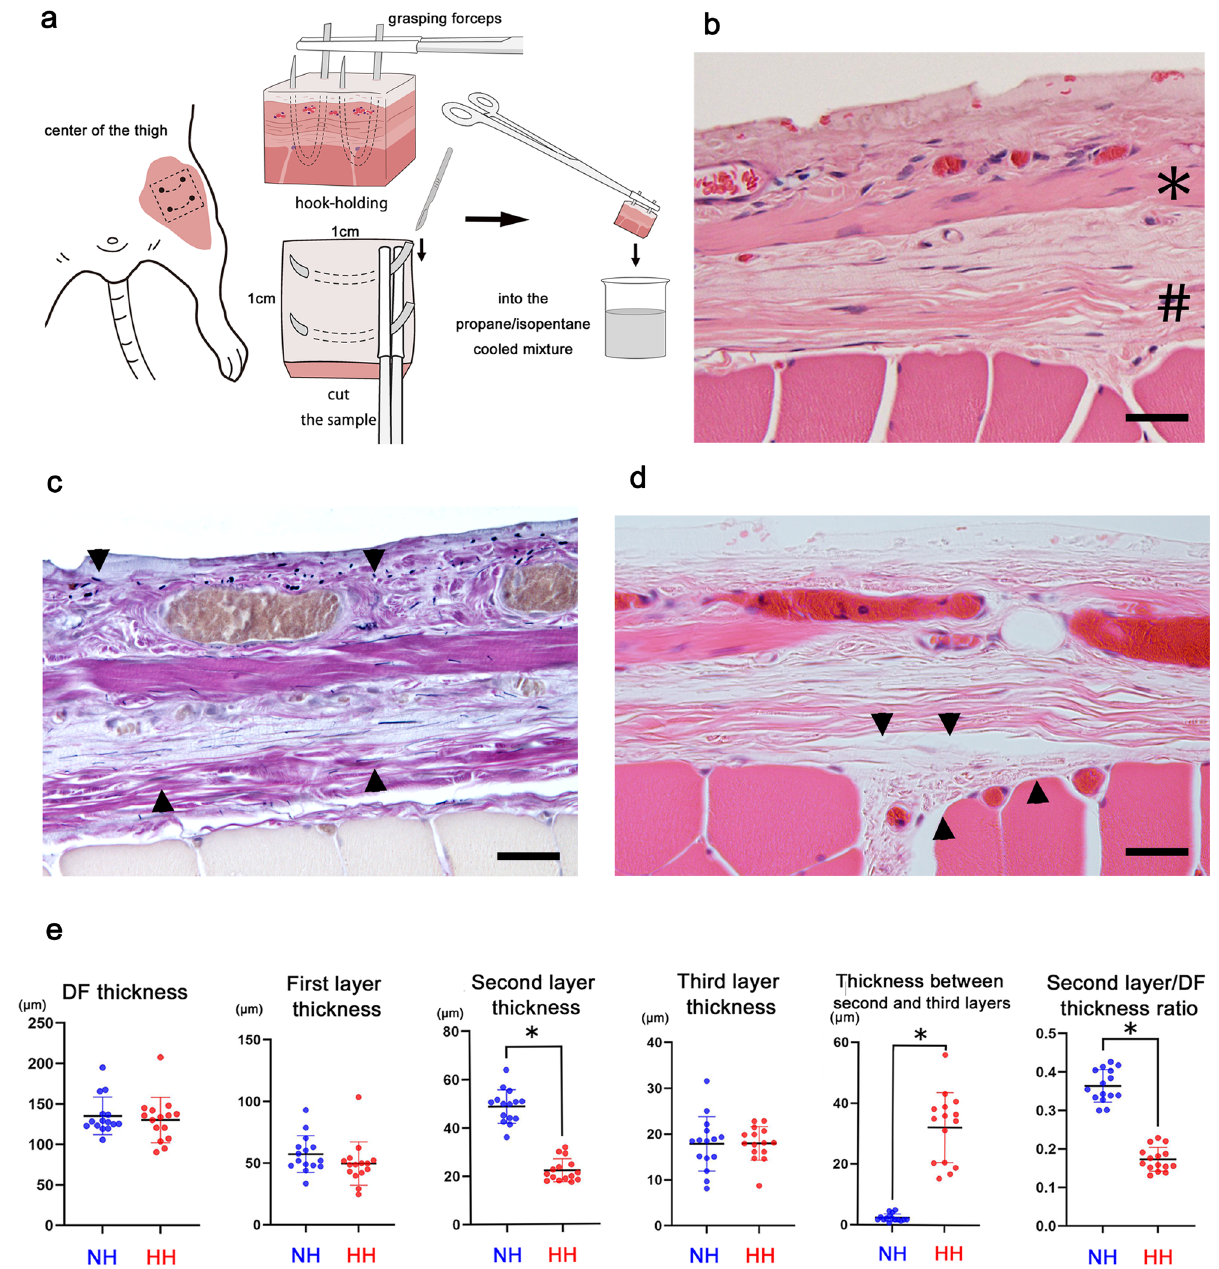
Figure 4. Plunge freezing followed by freeze-substitution with the hook-holding procedure. ( a ) Scheme illustrating the hook-holding procedure. To retain the morphology, we held the deep fascia and rectus femoris muscle with two hooks and grasping forceps, then excised it at 1 cm 2 and plunged it into the cooled propane/ isopentane mixture. Subsequently, plunge freezing followed by freeze-substitution was carried out. ( b ) Hematoxylin–eosin (HE) stain. In the first superficial layer, collagen fibers extend in various directions along with vessels replete with erythrocytes. The second intermediate layer (*) contains single straight and thick collagen fibers. The third deepest layer (#) is composed of straight and thin collagen fibers. Lightly stained loose connective tissue is observed between the second and third layers. Scale bar = 50 µm. ( c ) Elastika Van Gieson stain. Collagen bundles in the second intermediate layer are almost straight. Elastic fibers are observed in all layers of the deep fascia (arrowhead). Scale bar = 50 µm. ( d ) HE stain. The epimysium may exist independently of the third layer of the deep fascia and connected to the perimysium (arrowhead). Scale bar = 50 µm. ( e ) A quantitative comparison of the mean thicknesses of the deep fascia, first, second, and third layers, between the second and third layers, and the thickness ratio of the second layer to the deep fascia was conducted for 15 subjects per group. All data are presented as the mean ± standard deviation (SD). Statistical significance is determined using a Student’s t -test, with asterisks indicating statistically significant differences (*p < 0.05). NH, no hooks; HH, Hook-holding procedure; DF, deep